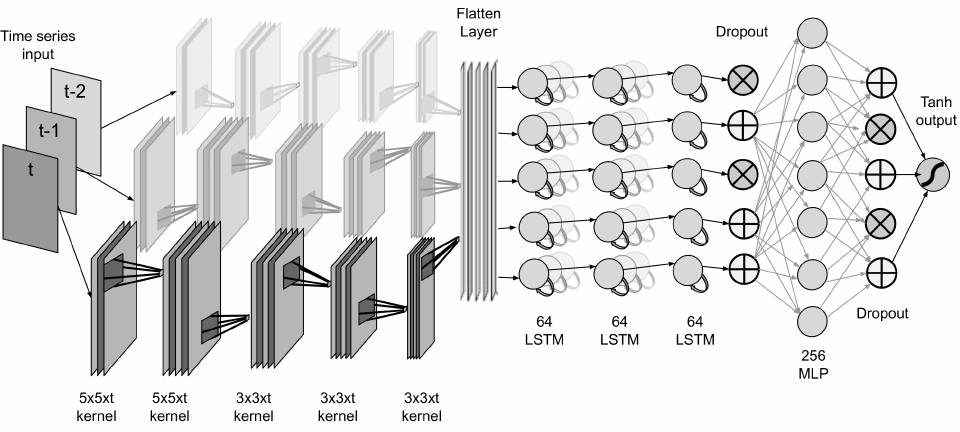
Figure 3. Time-distributed Chauffeur model [39].